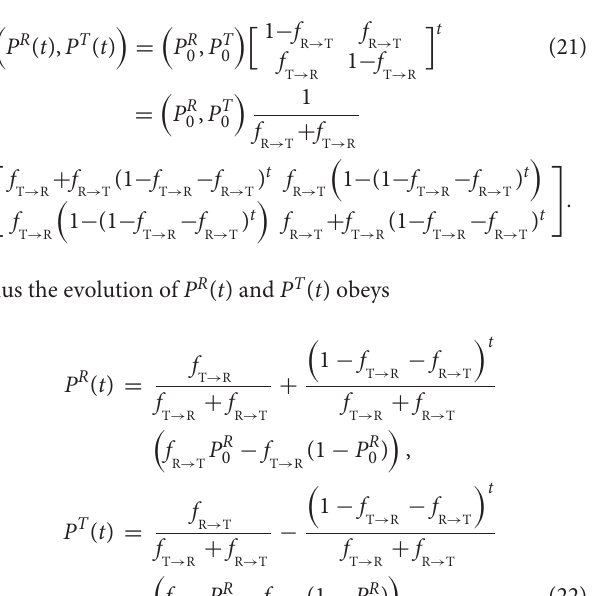
and f , and (D) speeds v R R → T T → R = 0.3, f = 0.5, and P R 0 = R → T T → R